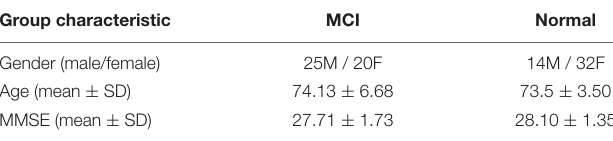
TABLE 1 | The specific group characteristics of the subjects. Group characteristic MCI Normal Gender (male/female) 25M / 20F 14M /